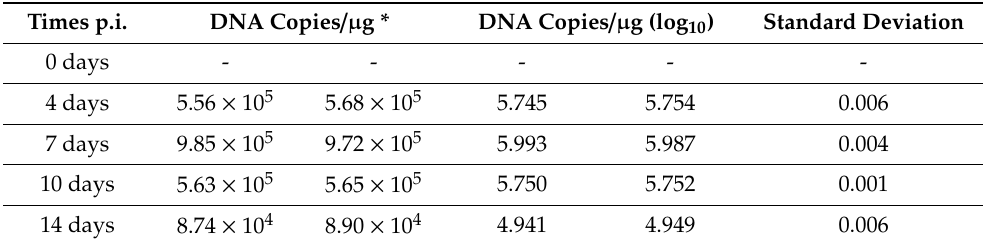
Table 2. Human herpesvirus 6A (HHV-6A) DNA quantitation in infected primary human dermal fibroblasts at the indicated times